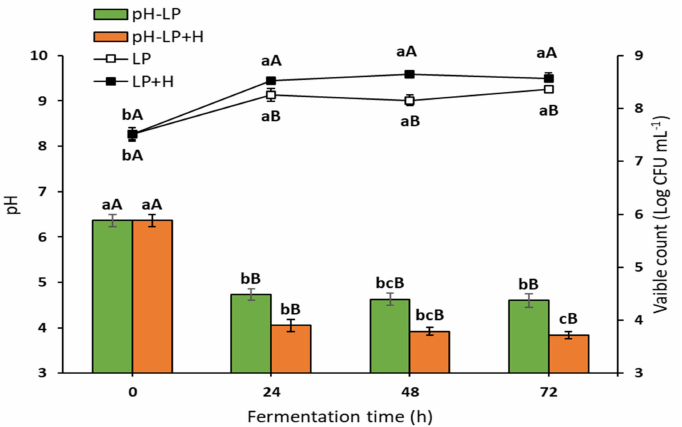
Figure 1. Viability of L. plantarum (Log CFU mL − 1 ) and pH value during fermentation (mean ± SE), n = 3. LP, L. plantarum count in plain media; LP + H, L. plantarum count in media with 2% Sidr honey; pH-LP, pH value of basic media during L. plantarum fermentation; pH-LP + H, pH value of media with honey during L. plantarum fermentation. a–c Bars or lines during the fermentation period not sharing similar letters are significantly different ( p > 0.05). A,B Bars or lines of each treatment not sharing similar letters during the fermentation time are significantly different ( p > 0.05).